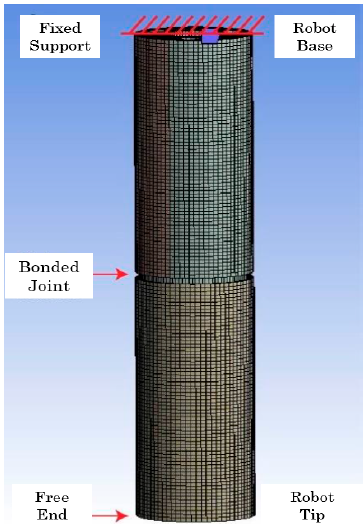
Figure 15. Boundary conditions in the simulation. Source: authors.